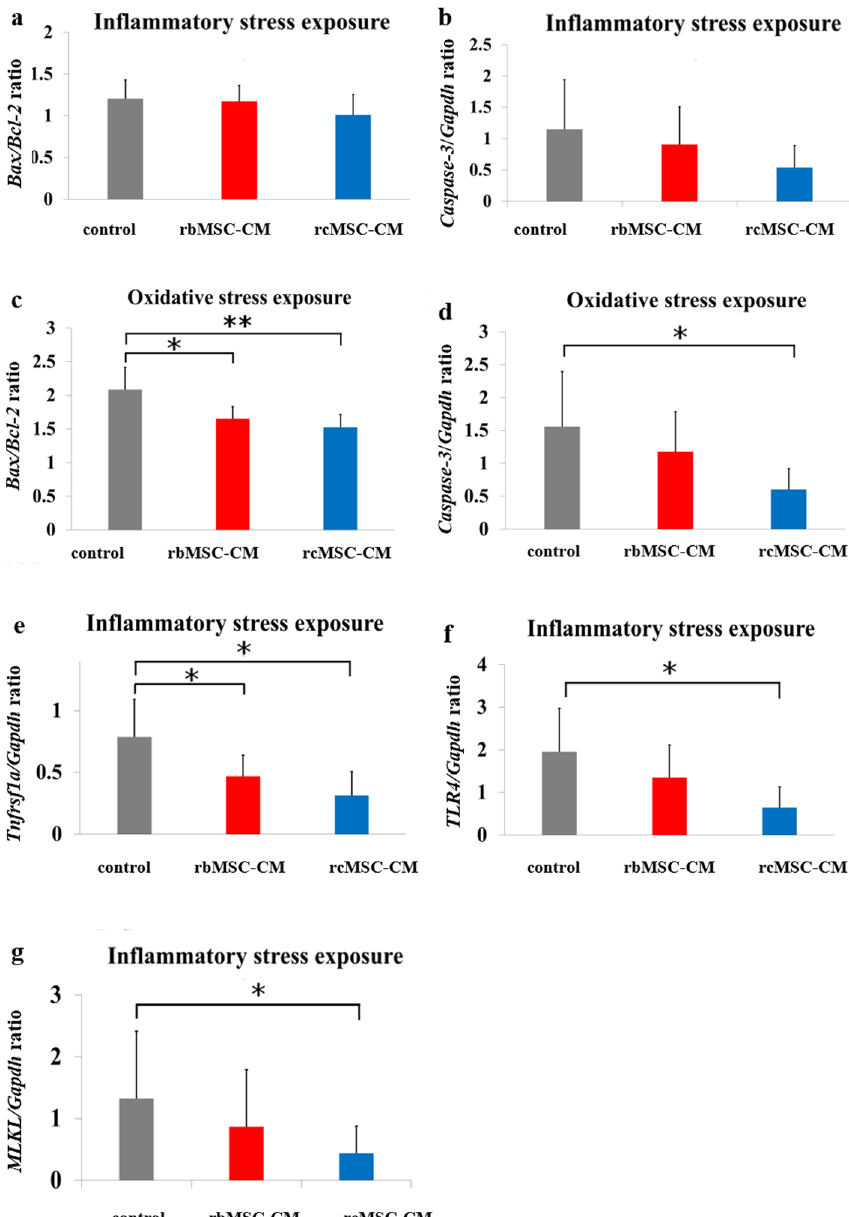
Figure 7. mRNA expression in stress-exposed NG108-15 cells. Relative mRNA levels of Bax/Bcl2 ( a ) and Casp3/ Gapdh ( b ) in inflammatory stress-exposed NG108-15 cells . mRNA levels of Bax/Bcl2 ( c ) and Casp3/Gapdh (d) in oxidative stress-exposed NG108-15 cells. mRNA levels of Tnfrs1a/Gapdh ( e ), Tlr4/Gapdh ( f ), and Mlkl/ Gapdh ( g ) in inflammatory stress-exposed NG108-15 cells . Data are presented as the mean ± SD of independent experiments (* P < 0.05 and ** P < 0.01, respectively, n = inflammatory stress-exposed: 9, oxidative stress-exposed: